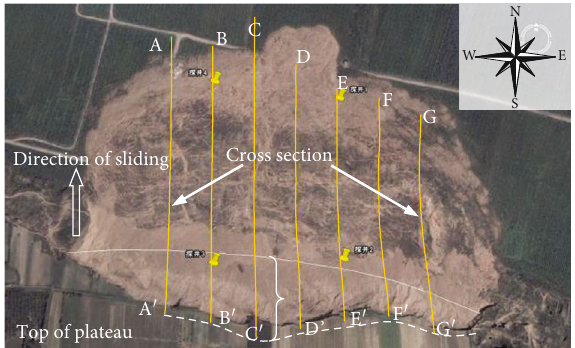
Figure 7: General view of landslide and